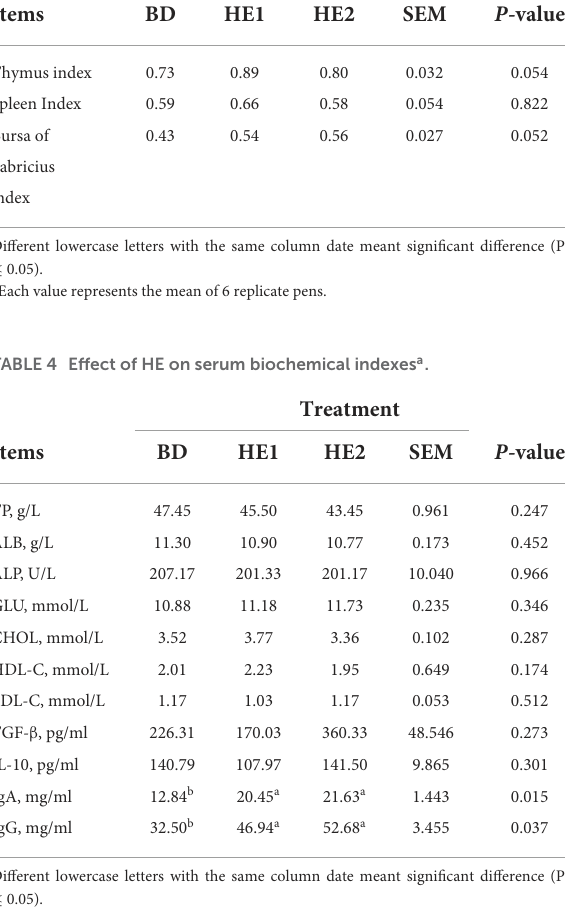
tip (with a lamina propria) of the villus to the base (villus-crypt junction), crypt depth (CD) was measured from the villus-crypt junction to the distal limit of the crypt, and villus